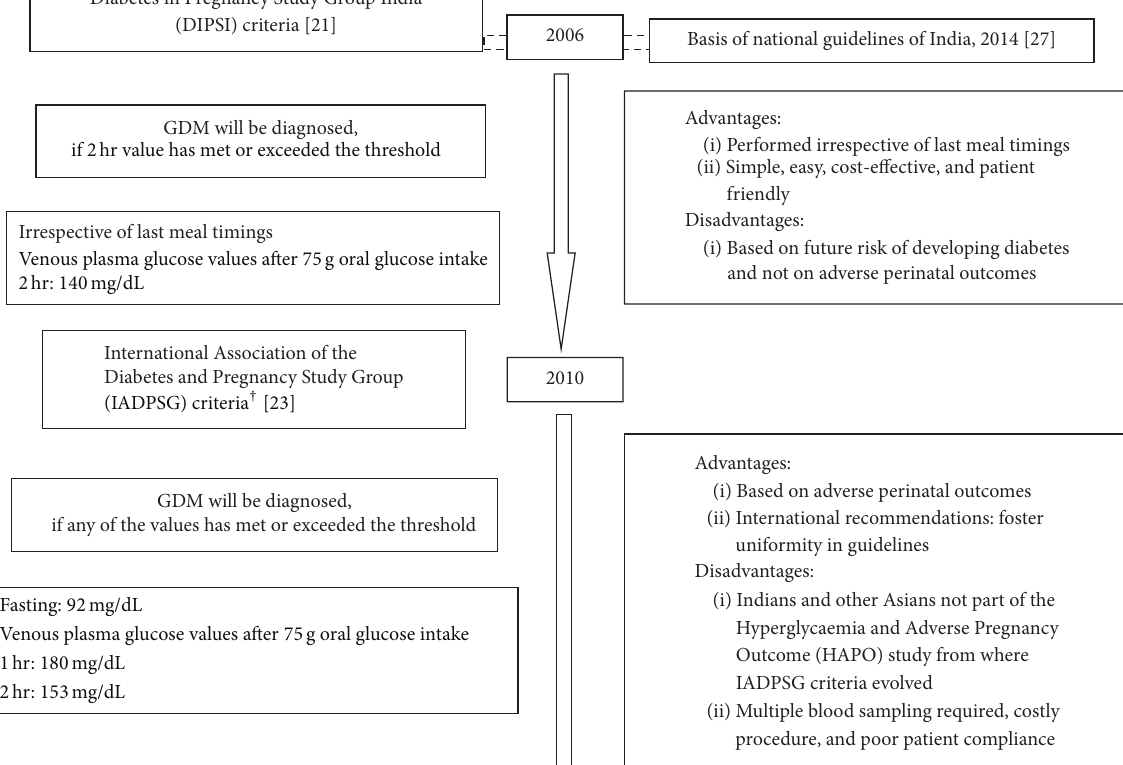
Figure 1: Evolution of different diagnostic criteria for